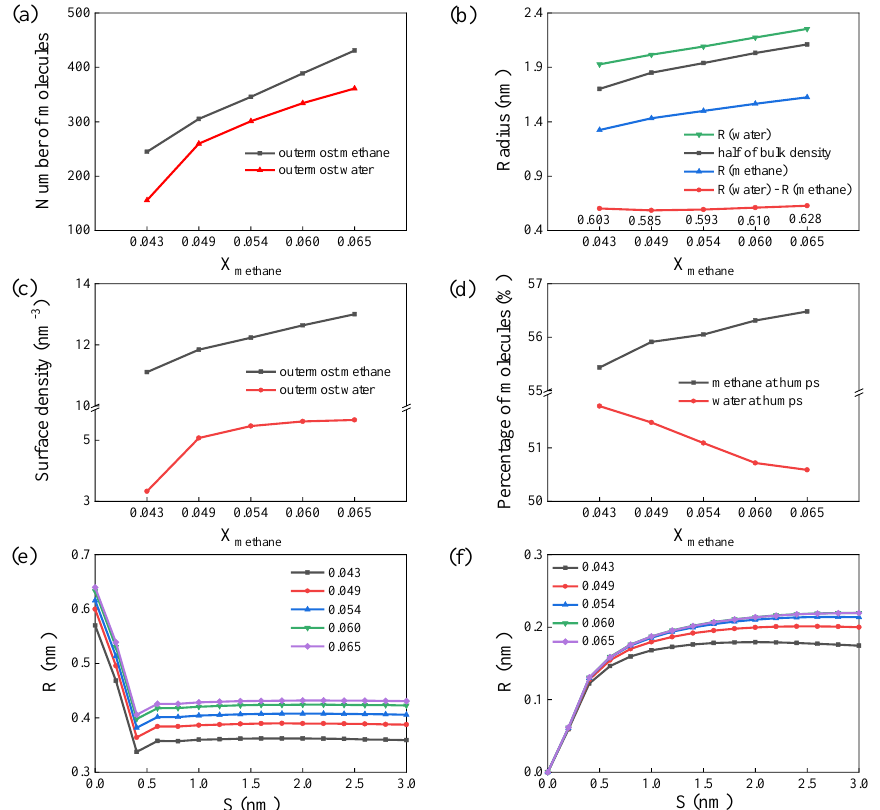
Figure 8. Time averages of ( a ) the total numbers of the outermost methane and water molecules, ( b ) bubble radii, ( c ) the surface densities of the outermost methane and water molecules, ( d ) the percentages of methane and water molecules at humps, and R as a function of S for ( e ) the outermost methane molecules and ( f ) the outermost water molecules in systems with different values of X methane at 313.15 K and 8 MPa.